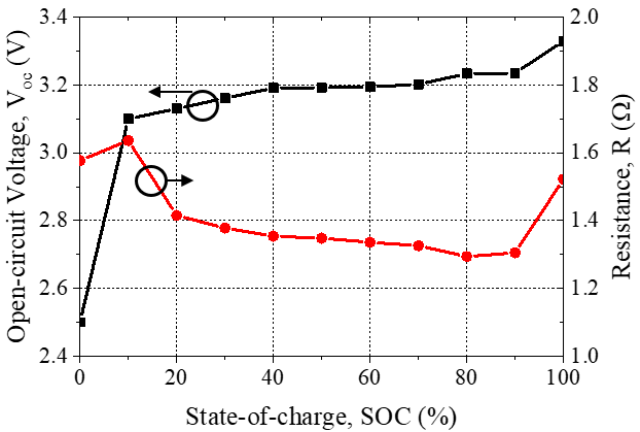
Figure 21. Open-circuit voltage and resistance versus state-of-charge.